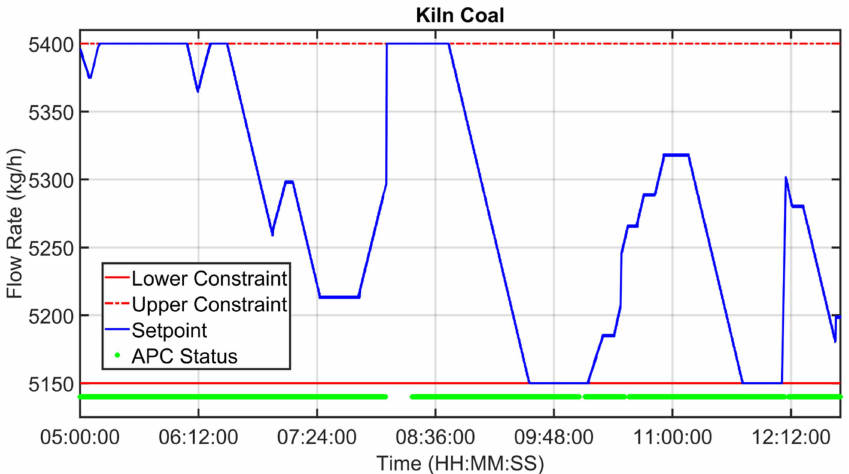
Figure 25. Rotary kiln APC system: field results (kiln coal